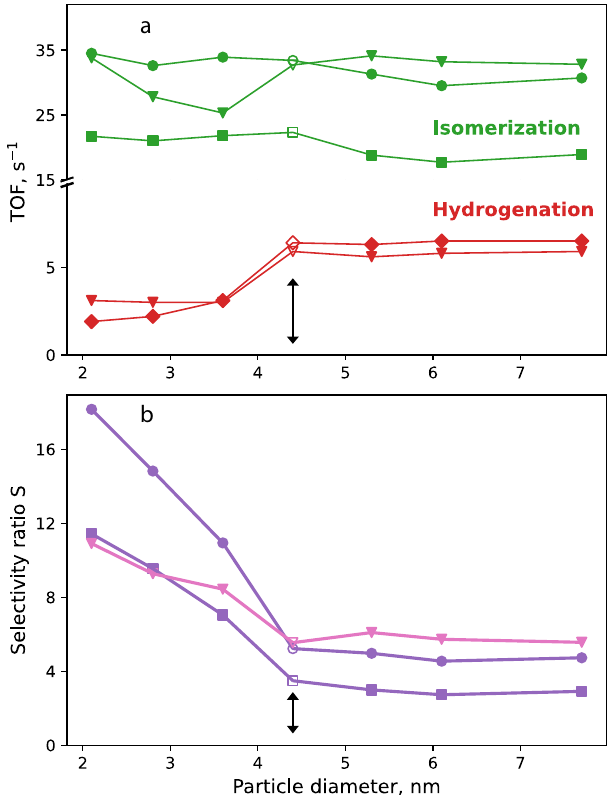
Fig. 4 Catalytic performance of Pd/Al 2 O 3 /NiAl(110) catalysts as a function of the average size of the Pd NPs. a Turnover frequencies (TOFs) of isomerization (green) and hydrogenation (red) of 1-butene at 373 K and b selectivity ratio S , of TOFs of isomerization vs. hydrogenation from experiment (purple) or modeling (pink). Data points from experiment (trans + cis-2-butene — discs, trans-2-butene — squares, n-butane — diamond), and modeling (inverted triangles); special case of 4.4 nm labeled by empty symbols, all other data represented by solid markers. Double arrows indicate the trend change in selectivity ratio. Modeling of isomerization focused on the trans -2-butene